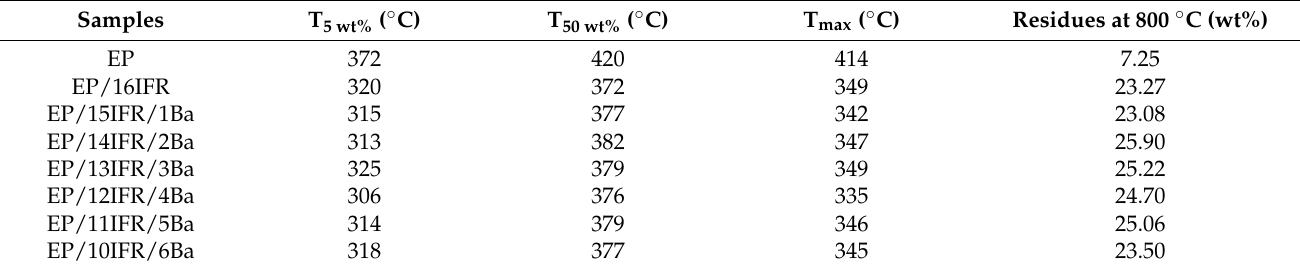
Figure 3. ( a ) TGA and ( b ) DTG curves of pure EP and EP composites in nitrogen. Table 2. TGA data of pure EP and EP composites obtained in nitrogen